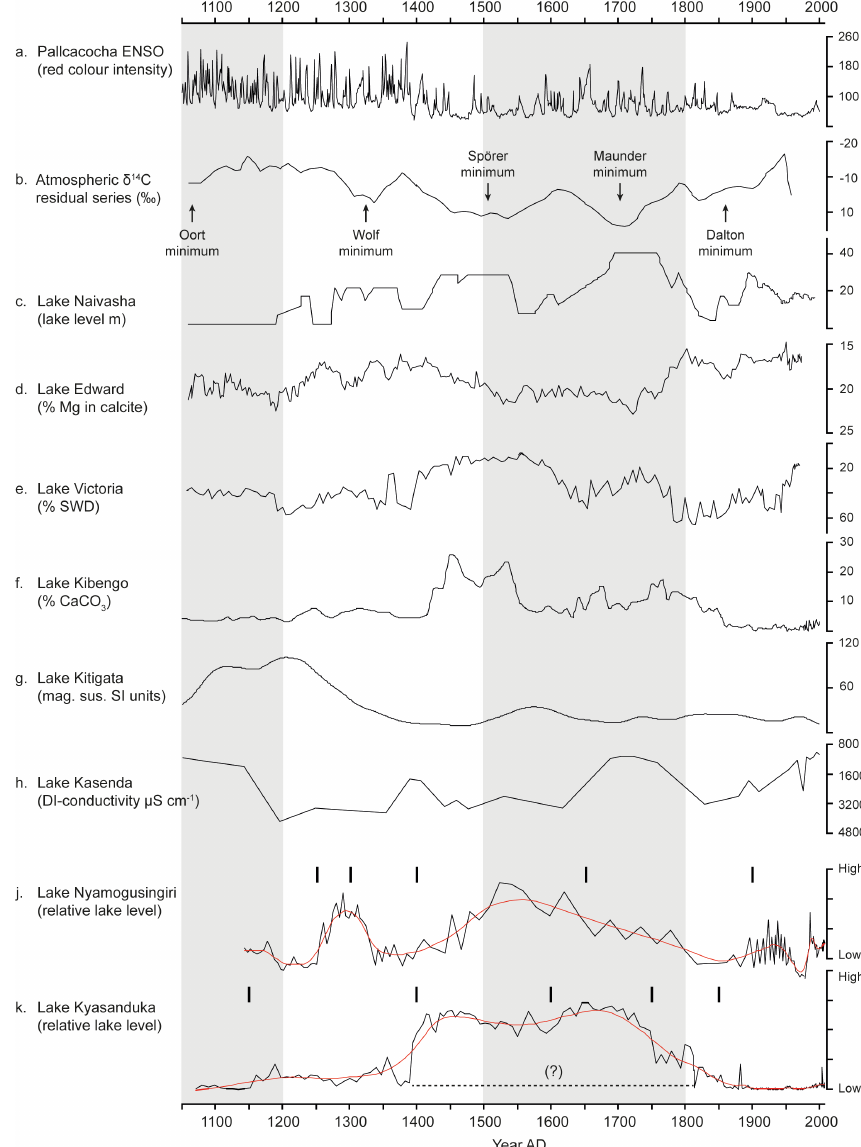
Figure 6. Comparison of climate drivers: (a) Laguna Pallcacocha ENSO frequency (Moy et al., 2002), (b) atmospheric 1 14 C residual series (sunspot minima; Stuiver and Brauzanias, 1989 – inverted y axis) and regional lake levels in East Africa: (c) Lake Naivasha lake level (Verschuren et al., 2000), (d) Lake Edward % Mg (Russell and Johnson, 2007 – inverted y axis), (e) Lake Victoria shallow water diatoms (Stager et al., 2005 – inverted y axis), (f) Lake Kibengo % CaCO 3 (Russell et al., 2007), (g) Lake Kitigata magnetic susceptibility (Russell et al., 2007) and (h) Lake Kasenda DI conductivity (Ryves et al., 2011 – inverted y axis). Inferred lake levels from (j) Lake Nyamogusingiri and (k) Lake Kyasanduka are also shown alongside statistical zones (short parallel lines above the curves); the smoothed lake-level curve for both lakes (red) was constructed using a lowess smooth (0.1 span) in C2. The alternative lake level for Kyasanduka is shown by the dashed line, which indicates a lower lake level if the control on the diatom species abundance is controlled by the Si:P ratio. The shaded areas represent the MCA (AD 1000–1200) and the main phase of the LIA (AD